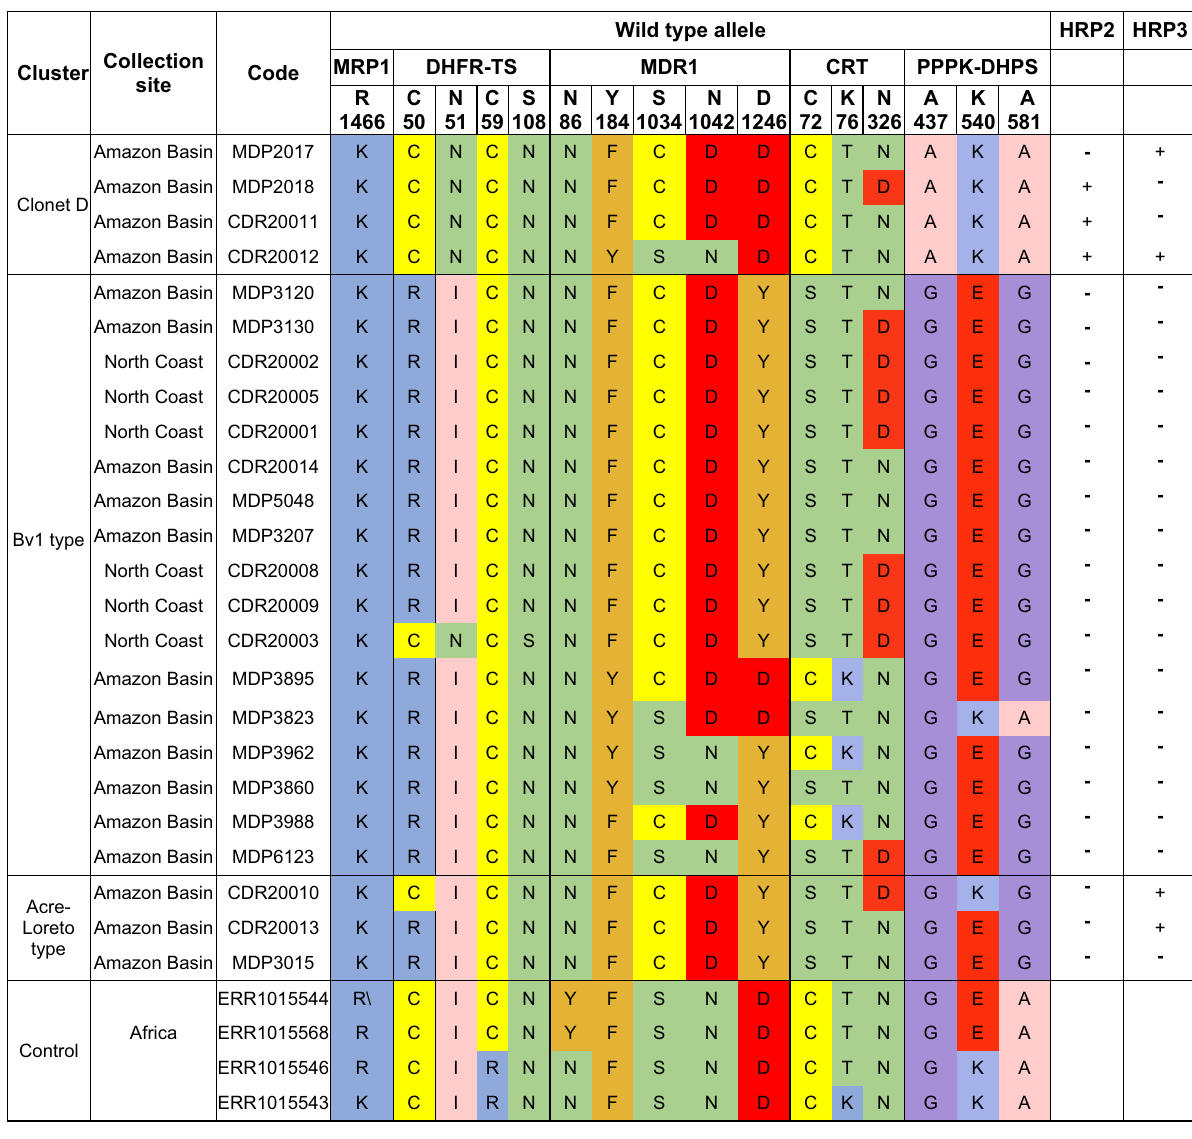
Table 1. Multilocus drug resistance haplotypes. The table shows SNPs on drug resistance genes on Peruvian and control African samples and pfhrp2 and pfhrp3 presence based on coverage. The table is divided into three clusters according to the subpopulation structure. Colors on the amino acids indicate amino acid change according to the Zappo color scheme (Aliphatic/hydrophobic in pink, aromatic in orange, positive in blue, negative in red, hydrophilic in green, conformational special in magenta and cysteine in